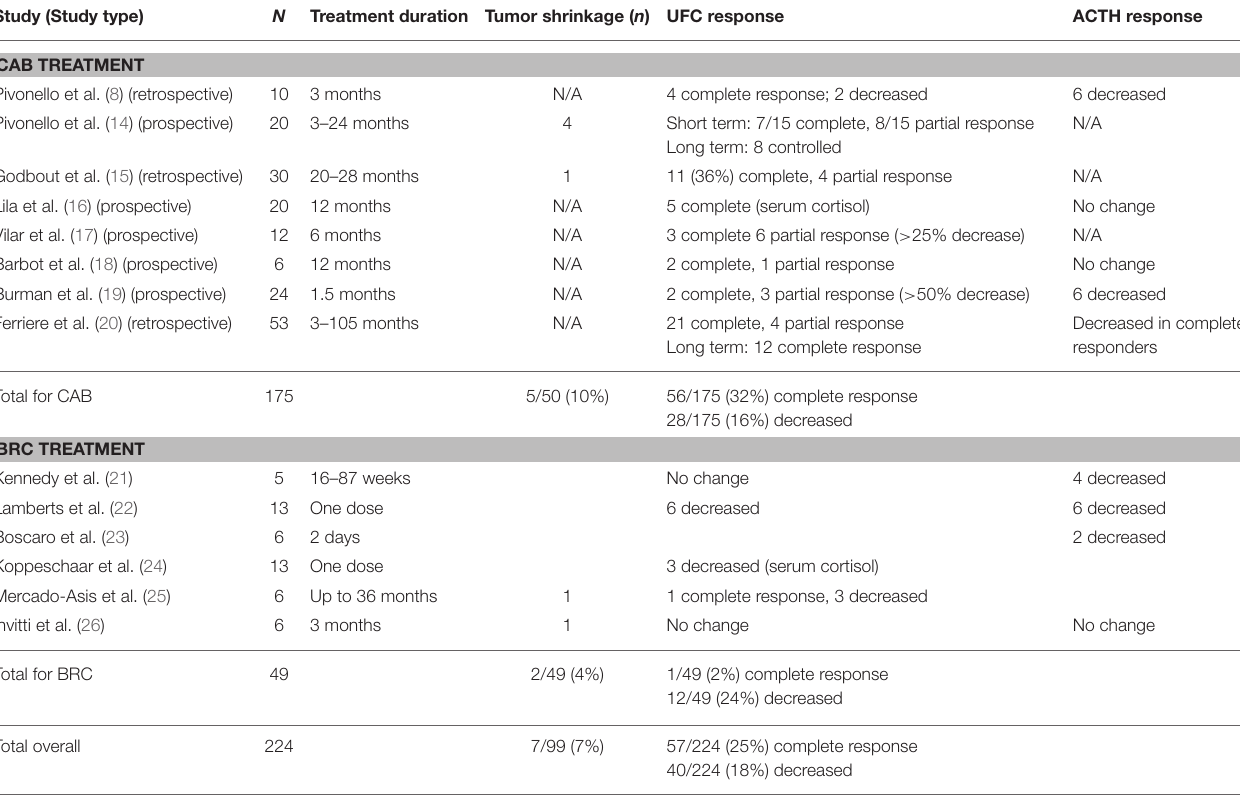
TABLE 1 | Response to dopamine agonists in Cushing’s